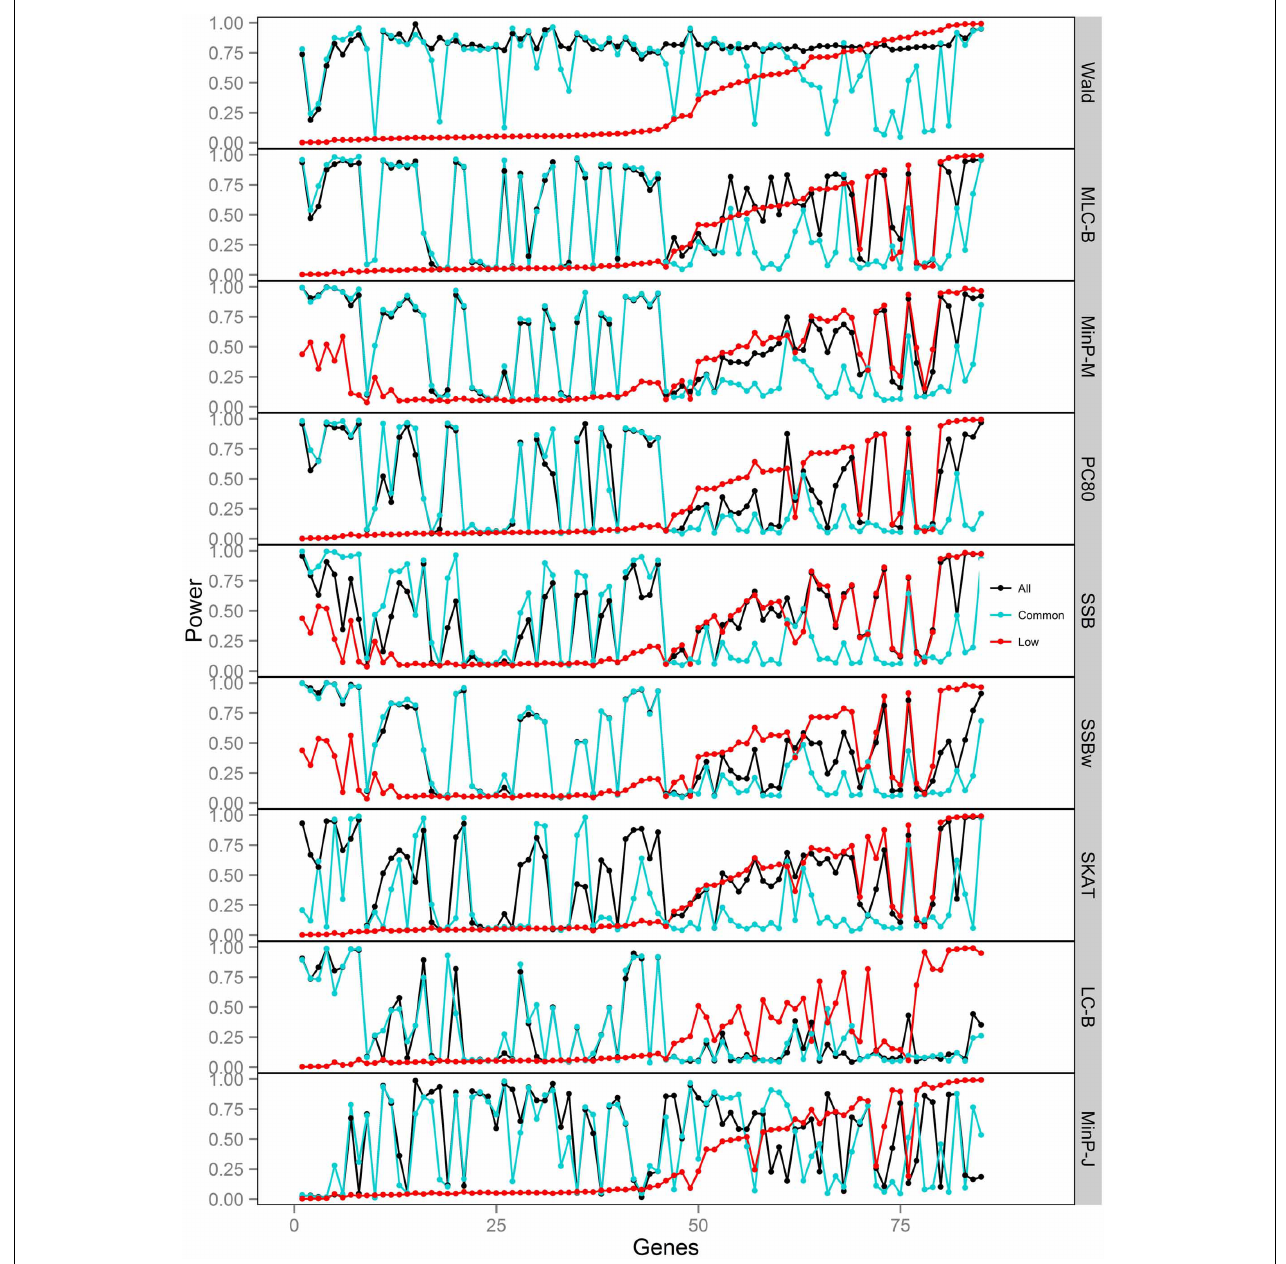
FIGURE 5 | Power of gene-based tests using three analysis sets of SNPs for 85 genes under trait Model 3. Genes are ordered along the horizontal axis according to the empirical power of Wald test using only low frequency